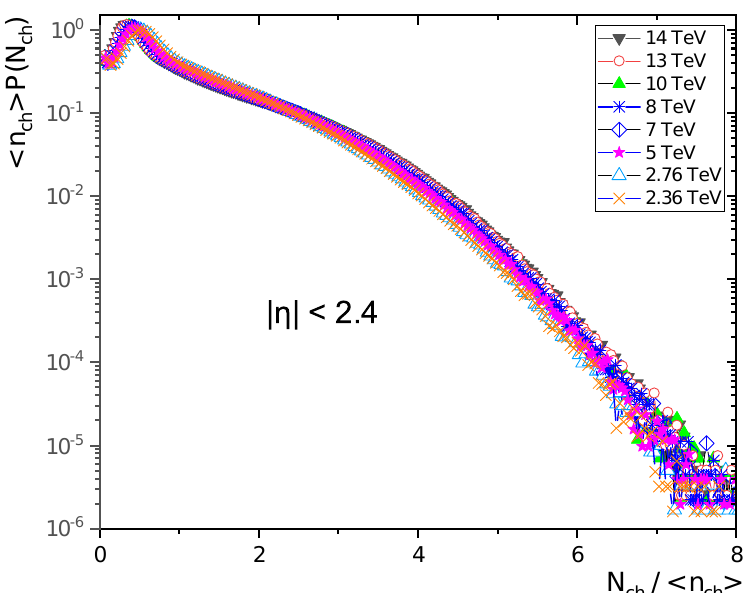
Figure 11. KNO form of charged particle multiplicity distribution at different energies in pseudora- pidity | η | <